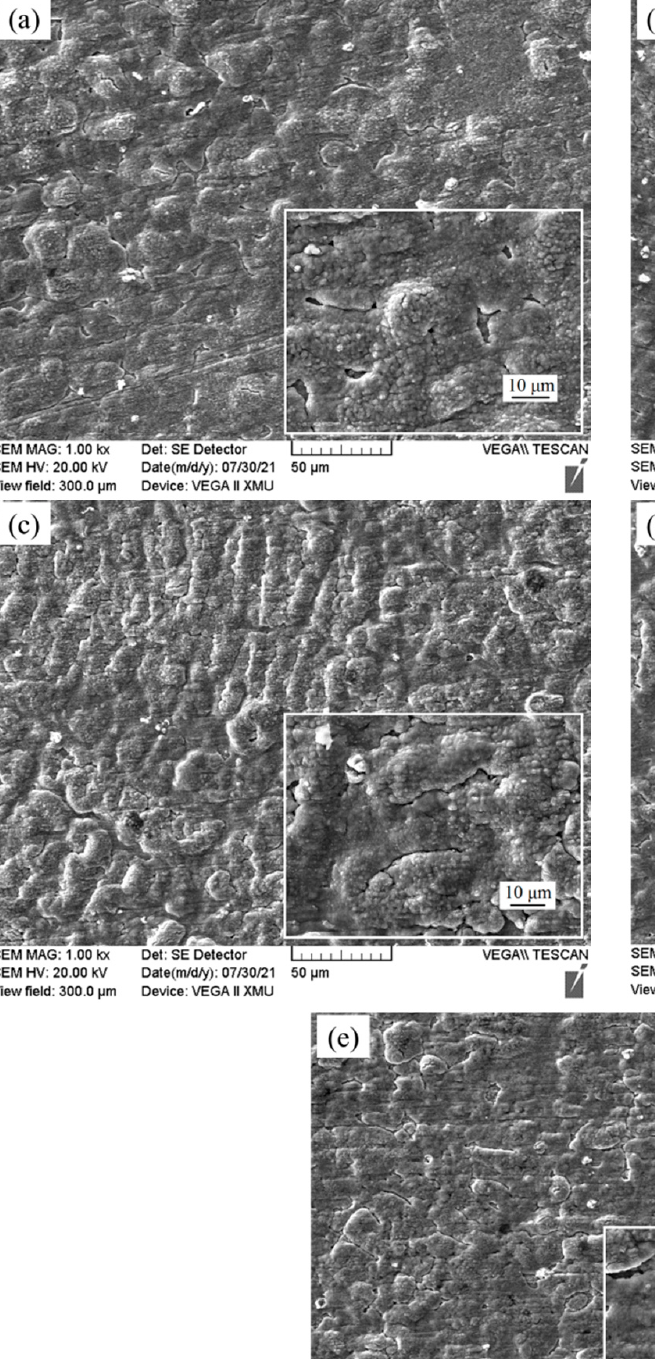
Figure 8. The micrograph for the surface morphology of Fe-25Mn-9Al-8Ni-1C-xTi alloy before the oxidation. ( a ) 0 wt.% Ti; ( b ) 0.1 wt.% Ti; ( c ) 0.2 wt.% Ti; ( d ) 0.3 wt.% Ti; ( e ) 0.4 wt.% Ti.